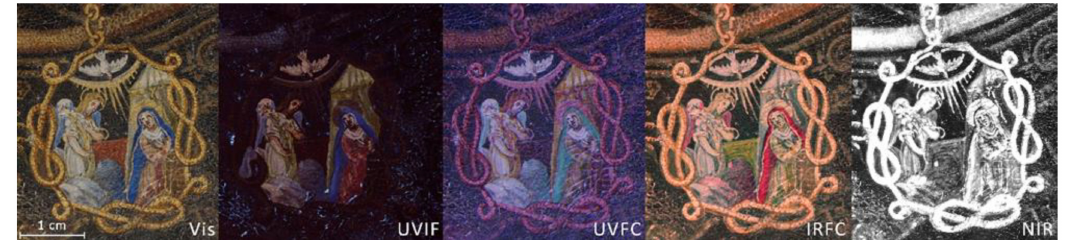
Figure 11. Multiband imaging sequence of the pendant with the image of the Santissima Annunziata.